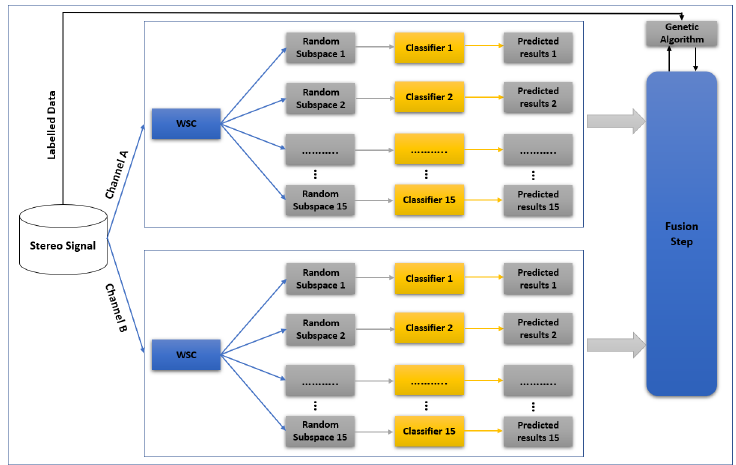
Figure 4. Block diagram of the training scheme of the proposed method.